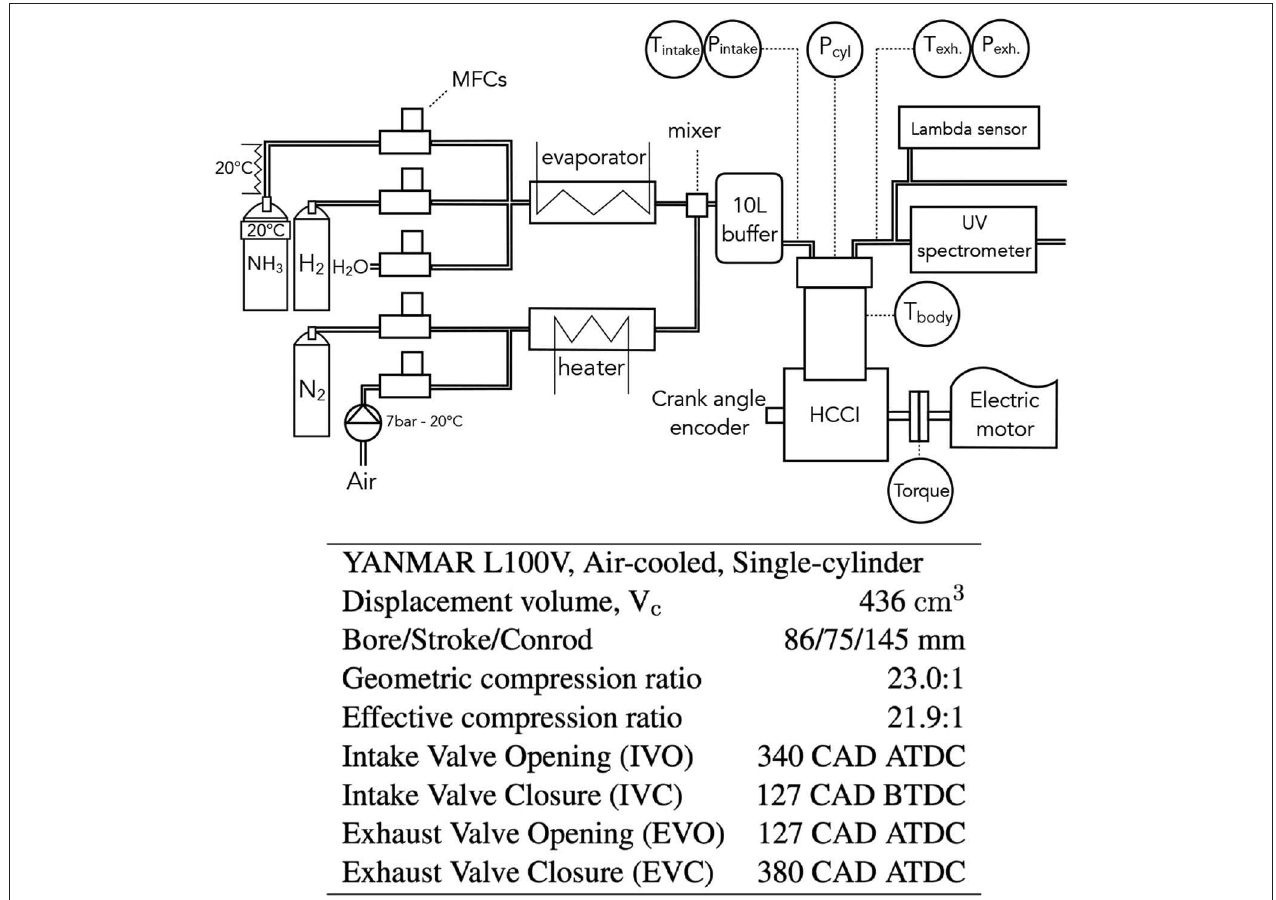
FIGURE 1 | Setup and engine specifications used for ammonia-hydrogen combustion and exhaust analysis at various intake temperatures, equivalence ratios, and synthetic EGR